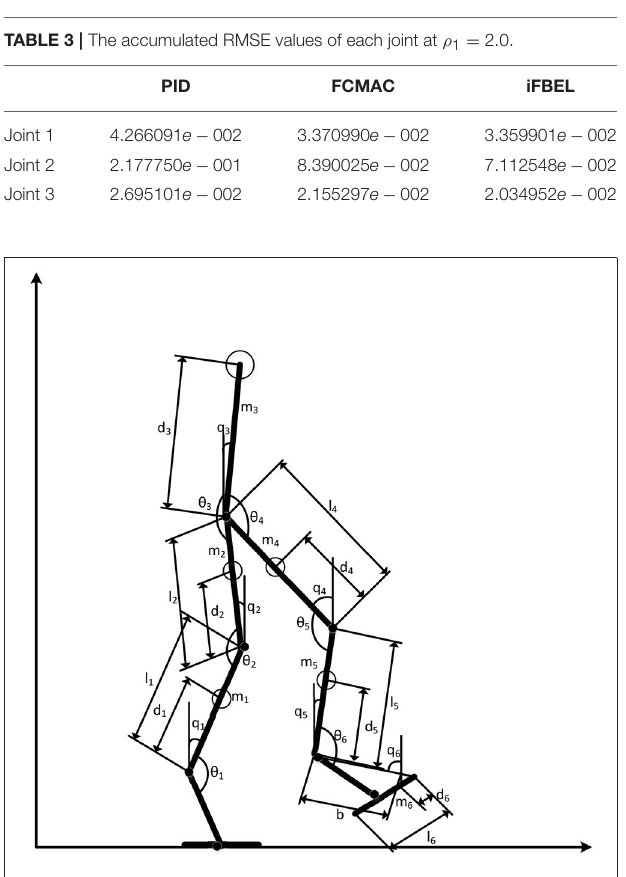
Frontiers in Neurorobotics |